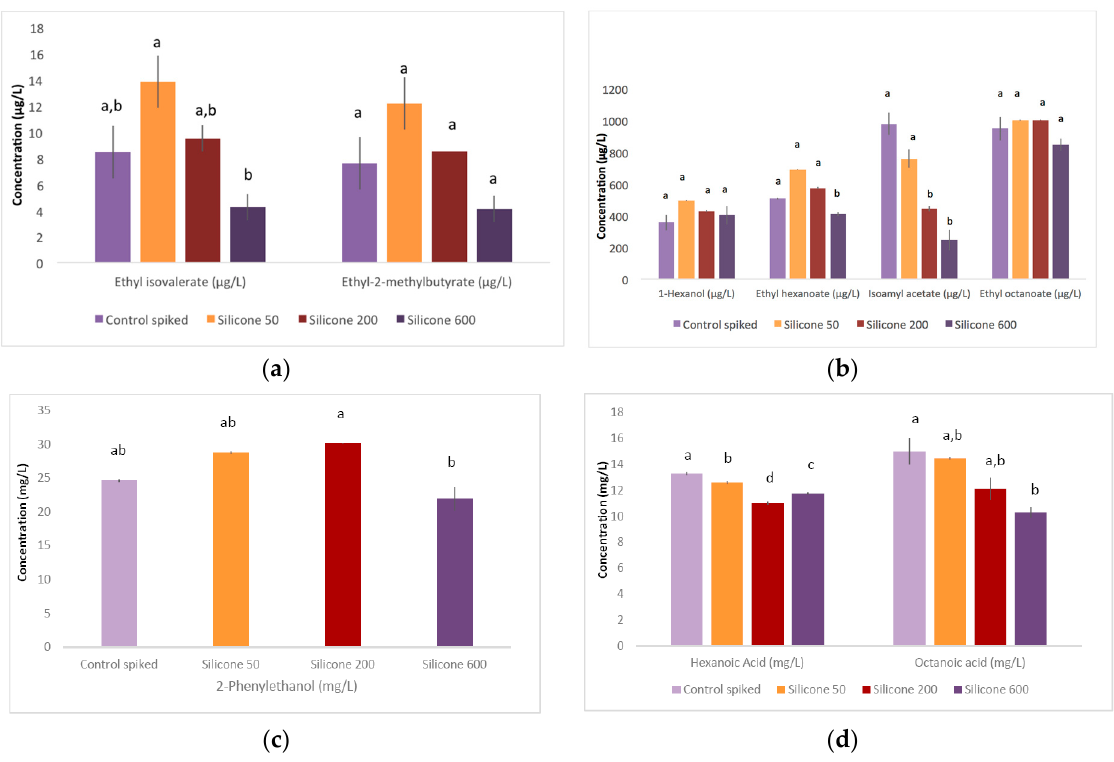
Figure 2. Concentrations of ( a ) ethyl isovalerate, ethyl 2 methylbutyrate; ( b ) ethyl butyrate, hexanol, ethyl hexanoate, isoamyl acetate, ethyl octanoate; ( c ) phenylethanol and ( d ) hexanoic acid and octanoic acid in untreated (‘control spiked’) wine and wine treated with silicone of varying surface areas (50 cm 2 /L, 200 cm 2 /L and 600 cm 2 /L). Data represent mean values ± standard deviations. Wines with different letters have significantly different concentrations for each compound (Tukey’s HSD 0.05 ).